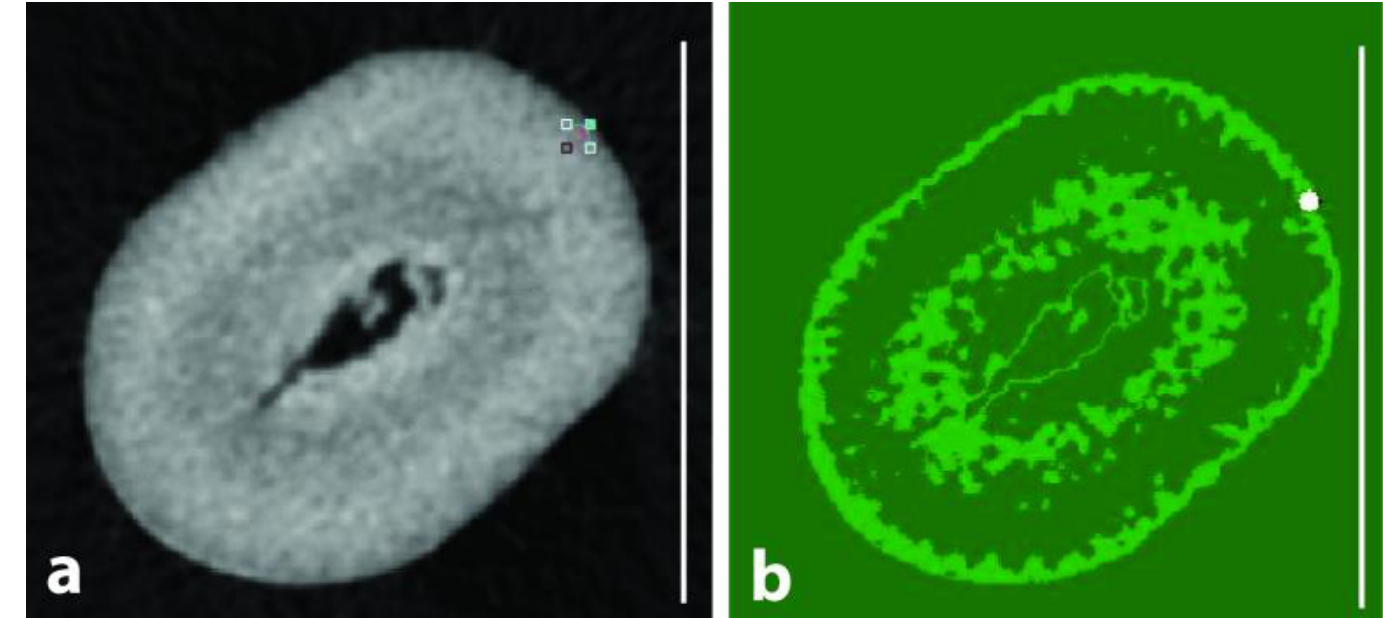
Fig. 2. a) Reconstructed Micro-CT cross section of the Franciscana Pontoporia blainvillei (UFSC 1310). b) Same specimen after threshold manipulation. Scale bar = 2